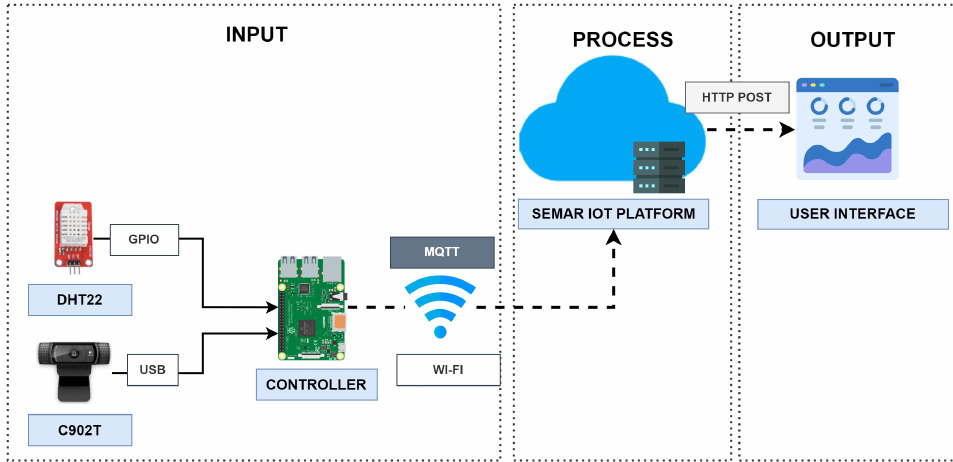
Figure 14. System overview of AC-Guide